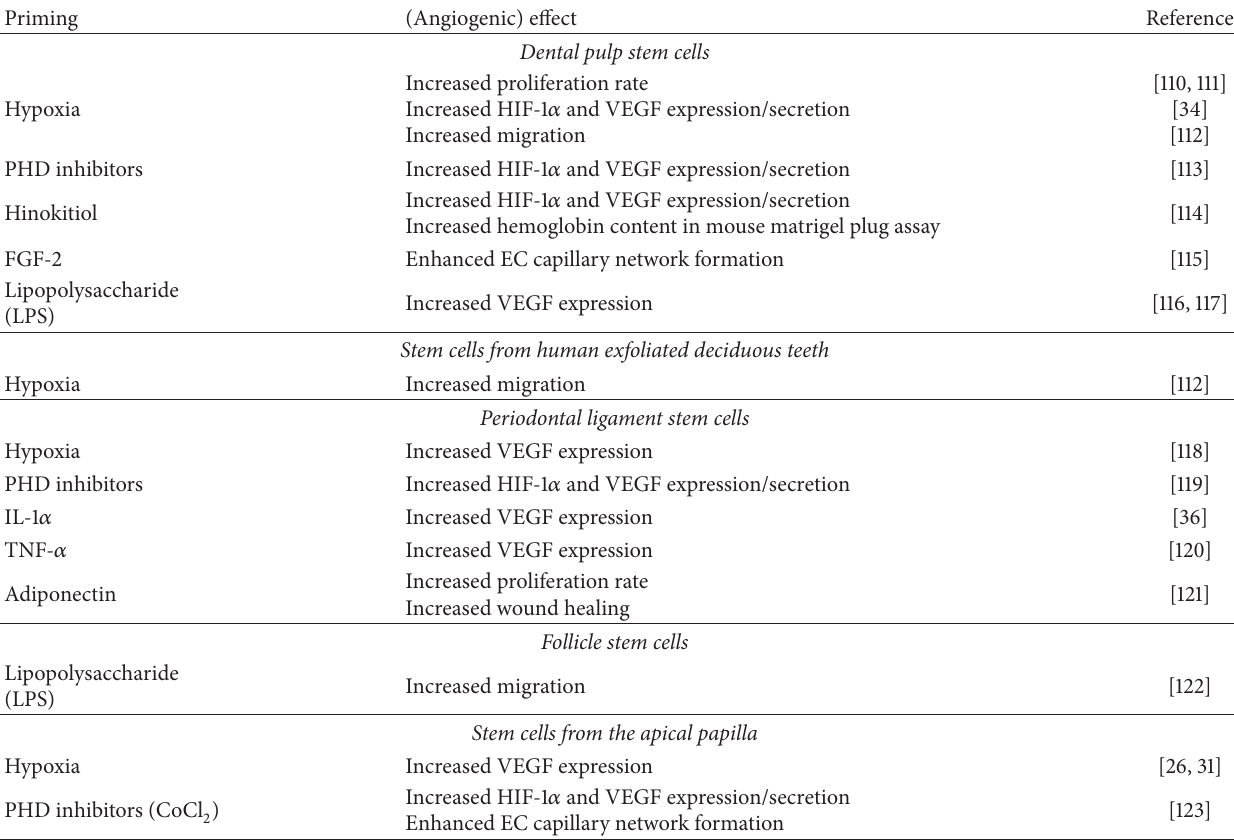
Table 2: Dental stem cells and the effects of